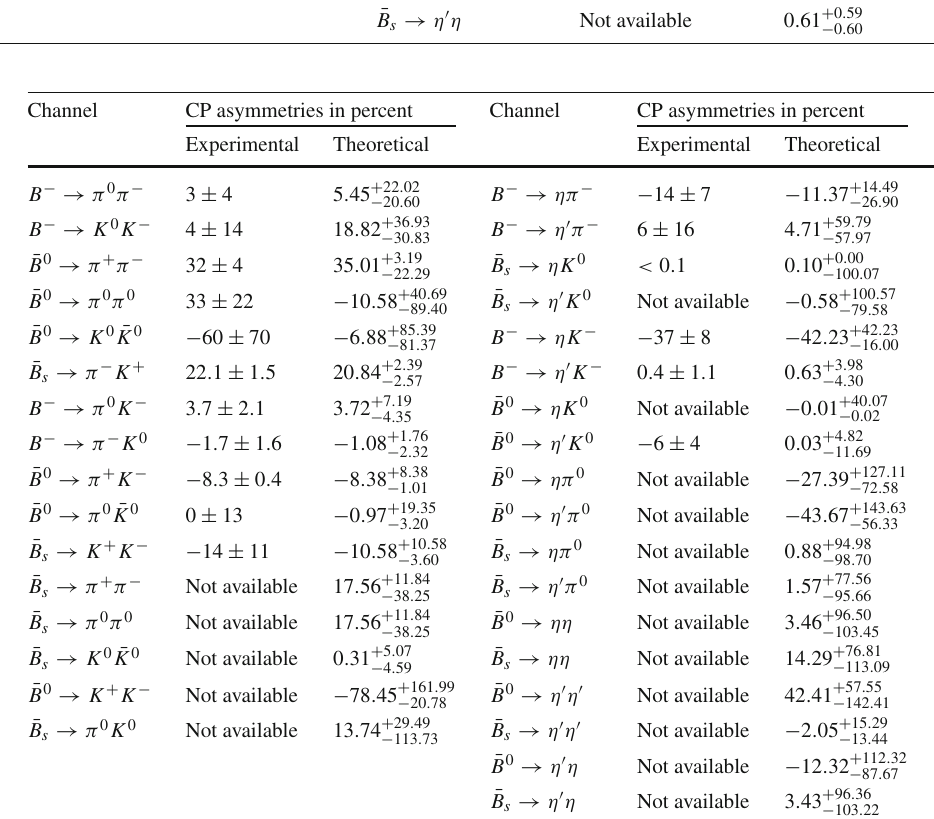
Channel CP asymmetries in percent